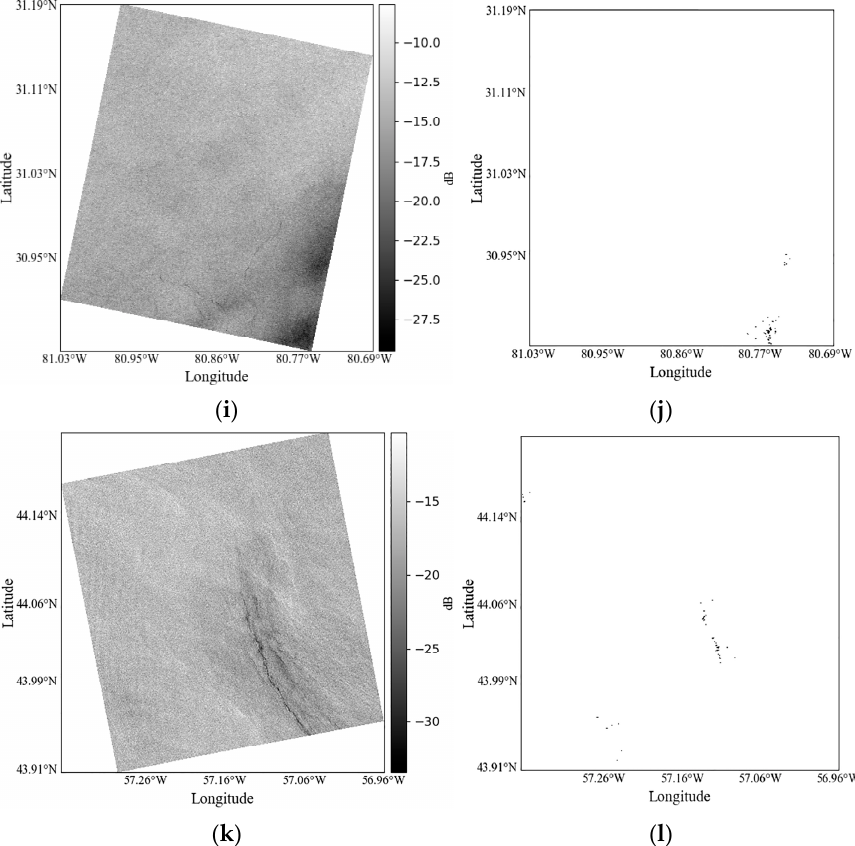
Figure 9. The preprocessed VV polarization images and oil spill detection results based on PR r and the Euclidean distance-based threshold method ( a , c , e , g ) are preprocessed σ 0 vv of oil spill Cases 1–4, respectively; ( b , d , f , h ) are oil spill detection results of oil spill Cases 1–4, respectively; ( i , k ) are preprocessed σ 0 vv of Cases 5 and 6, respectively; and ( j , l ) are detection results of Cases 5 and 6 based on the threshold method, respectively. The white area is seawater, and the black area is oil spill.